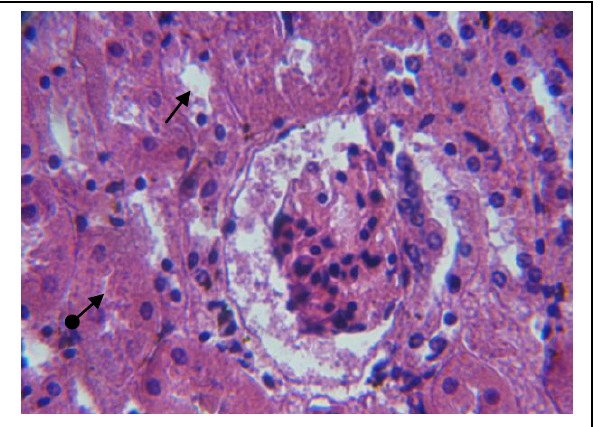
Figure(4):The lung was suffering from congestion,hyperplasia of epithelial lining of bronchiol( ),odema,thrombosis( )and thickening of alveolar wall due to lymphatic infiltration( )also around bronchiole (H&E